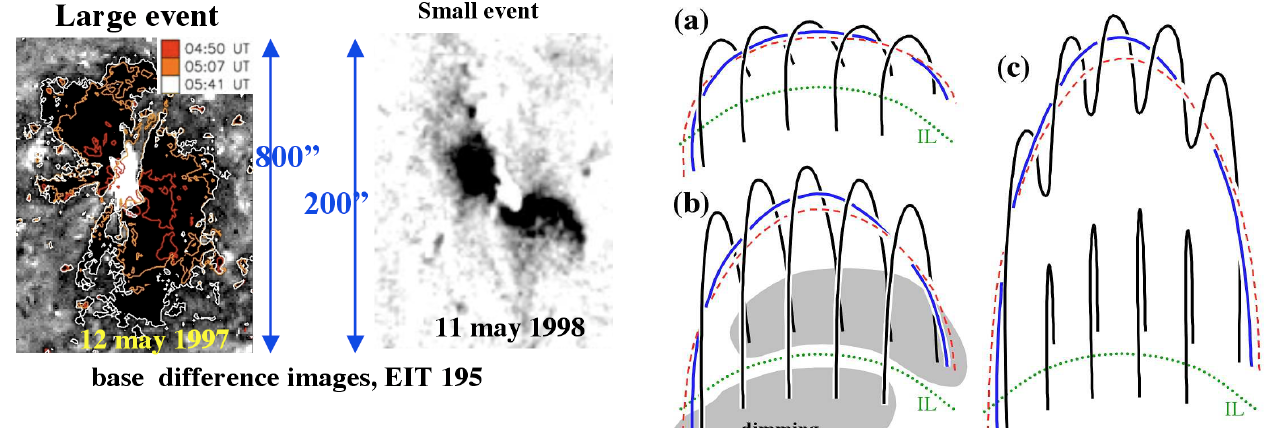
Fig. 12. Double dimmings for two eruptive events in similar bipolar magnetic fields. The large event occurred in a classical bipolar AR (Attrill et al., 2006), while the small event occurred in an ephemeral region (duration ≈ 2 days; Mandrini et al., 2005). The bipole and dimming magnetic fluxes are about 15 times larger in the first event than in the second. Despite this magnitude difference, these events have a similar organization both for the flare brightenings centered on the magnetic inversion line and for the dimmings shifted along it (both events have negative helicity). For the large event, the ex- pansion evolution of the dimmings is shown. The dimming contour level is set halfway between the intensity of the quiet Sun and of a coronal hole.